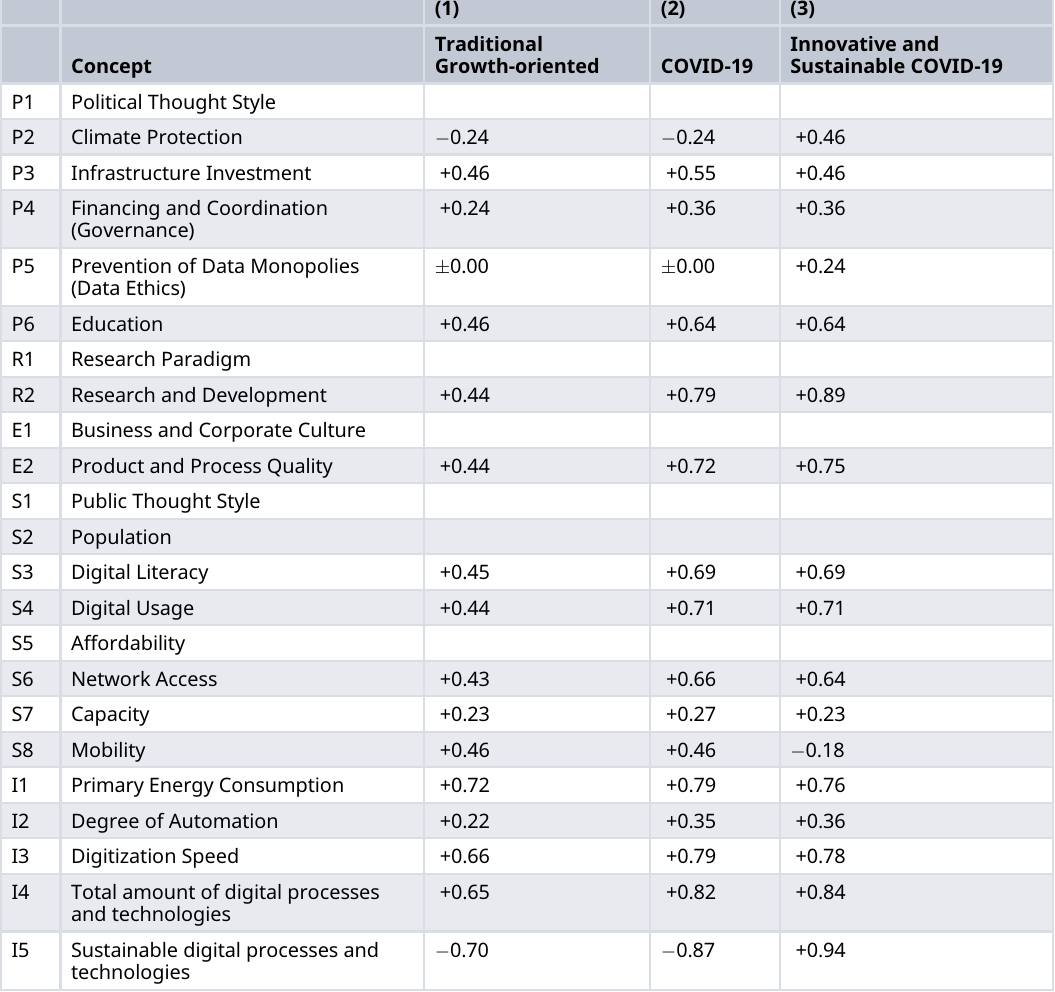
Table 13. Simulation results related to the three alternative